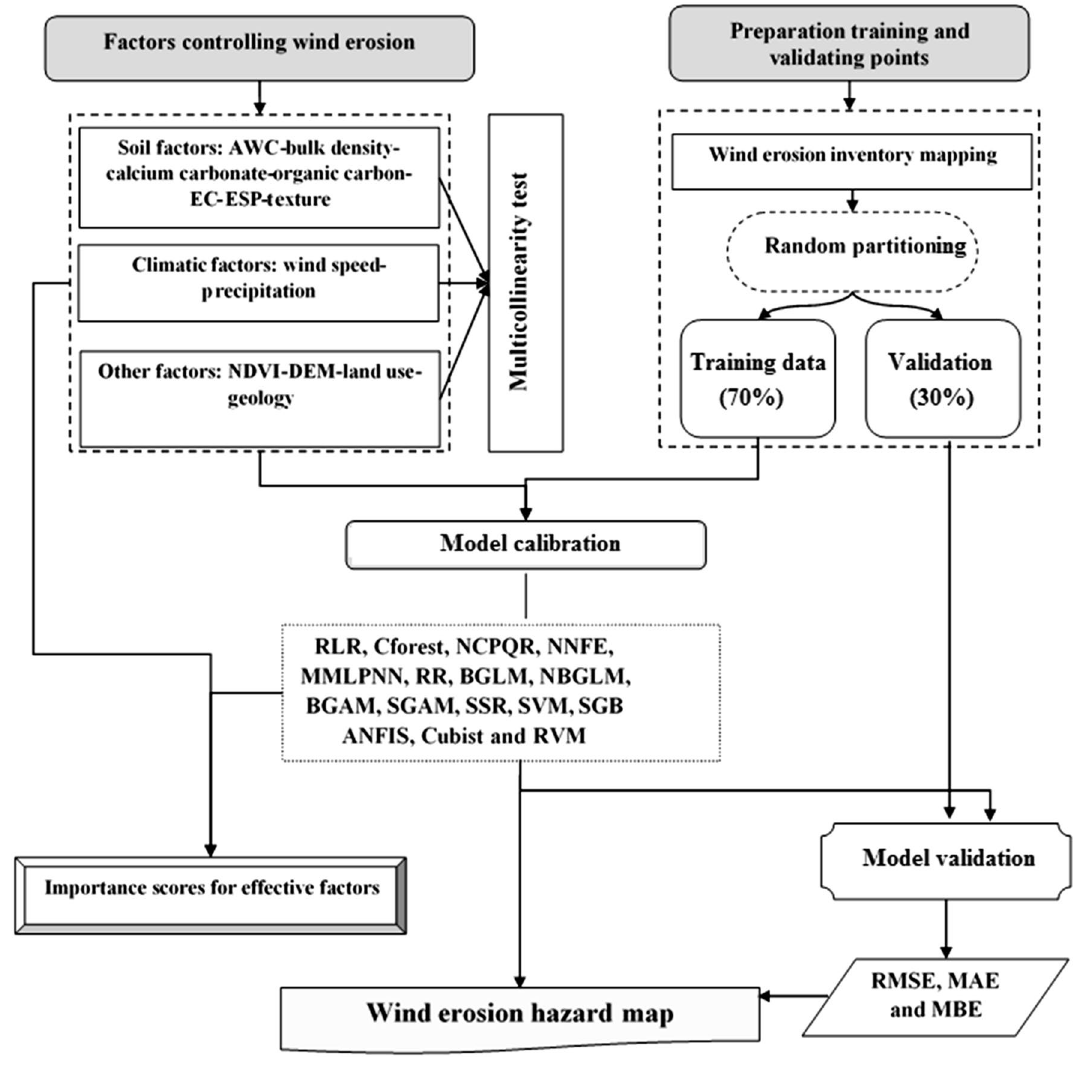
Figure 11. Flowchart of the methodology for mapping of wind erosion